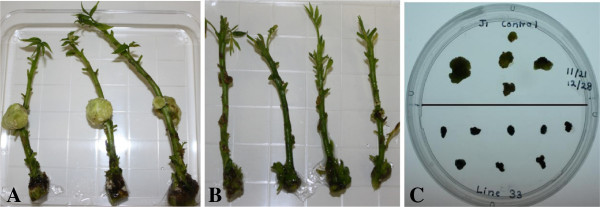
Suppression of A. tumefaciens tumorigenesis in oncogene-silenced walnut microshoots. Walnut microshoots were inoculated with virulent A. tumefaciens strain 20W-5A. A) Inoculation sites of untransformed microshoots formed large, undifferentiated tumors five weeks post-inoculation. B) Oncogene-silenced line 33-3-1 exhibited no tumor development. C) Small fragments of callus from A. tumefaciens inoculation sites cultured on hormone-free plant growth medium for five weeks: untransformed callus (upper) and callus derived from transgenic line 33-3-1 (lower).